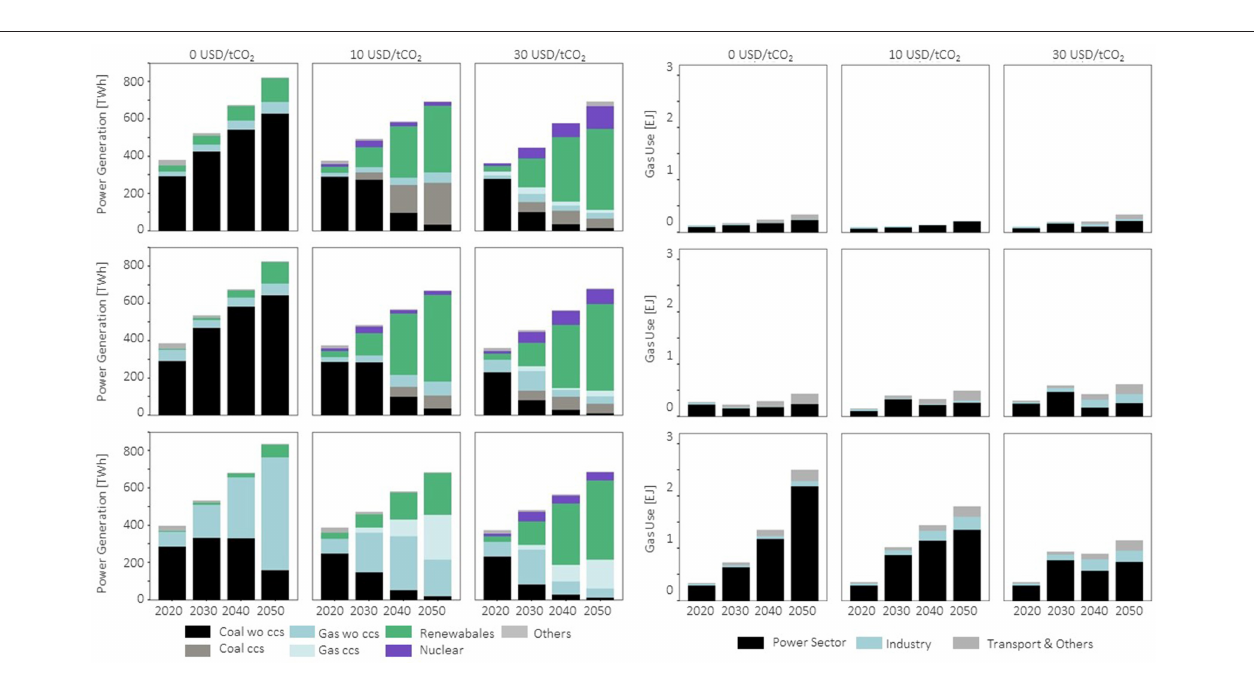
FIGURE 5 | (Left) Power generation and (Right) gas utilization in nine selected scenarios featuring three different carbon prices (from left to right: 0, 10, and 30USD/tCO 2 ), a scenario set without shale gas (top) and two sets at variable shale gas extraction costs (center: 3USD/GJ, bottom: